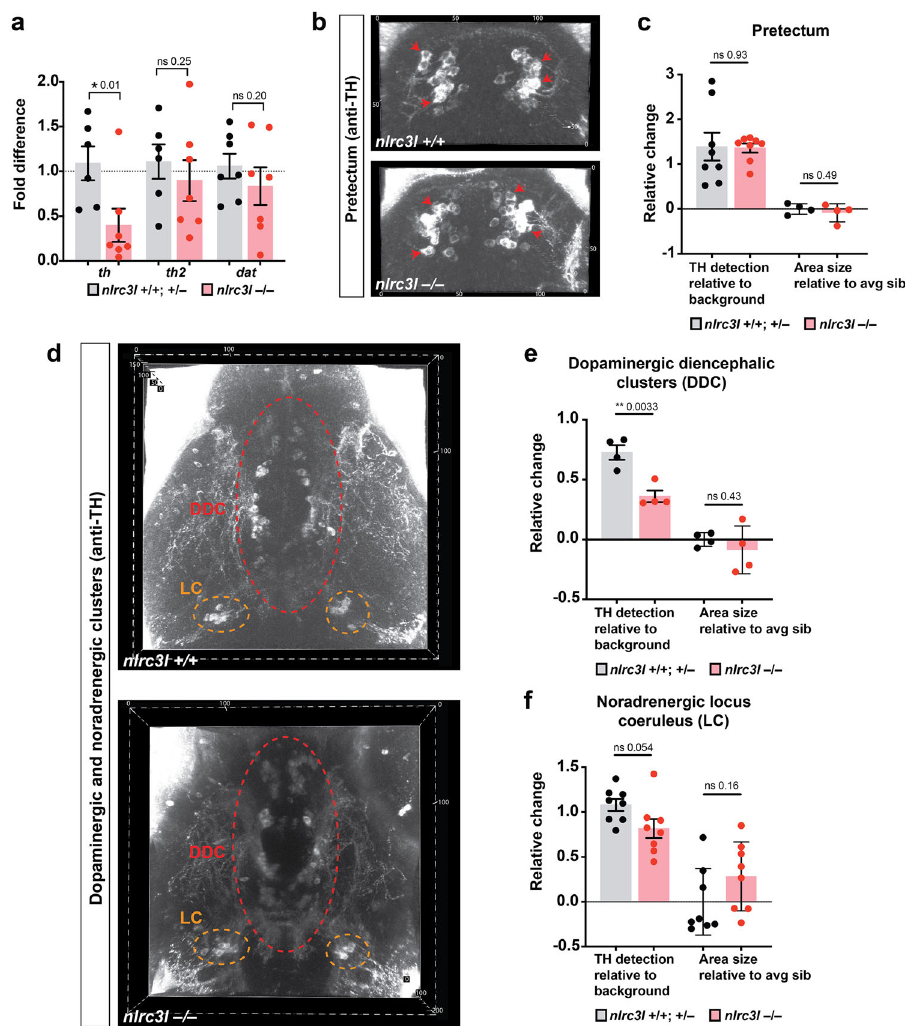
Fig. 6 Protein expression of the dopamine synthesis enzyme, tyrosine hydroxylase (TH), is strongly reduced in the dopaminergic diencephalic clusters (DDC) in nlrc3l mutants. a Bar chart conveys qPCR analysis of dopaminergic system genes ( th , th2 , and dat ), indicating a signi fi cant decrease in th mRNA expression in nlrc3l mutants. b Anti-TH immunostaining characterization of the pretectal dopaminergic neurons (red arrows) at 6 dpf shows no apparent difference between nlrc3l mutant and control wild-type. c Quanti fi cation of the relative TH protein level and relative area of TH + staining. d – f Characterization of the ventral larval brain at 6 dpf shows a large signi fi cant reduction in TH protein level in the posterior tuberculum of the DDC, and a modest and nearly signi fi cant decrease in the noradrenergic locus coeruleus (LC). Right, quanti fi cations of the relative TH protein level and relative area of TH + staining in the DDC and LC. c , e , f Area was determined relative to the average (avg) area size of wild-type and heterozygous siblings (sib). Two- tailed t -test was used to determine statistical signi fi cance. Error bars show standard error of mean for relative TH staining and standard deviation for relative